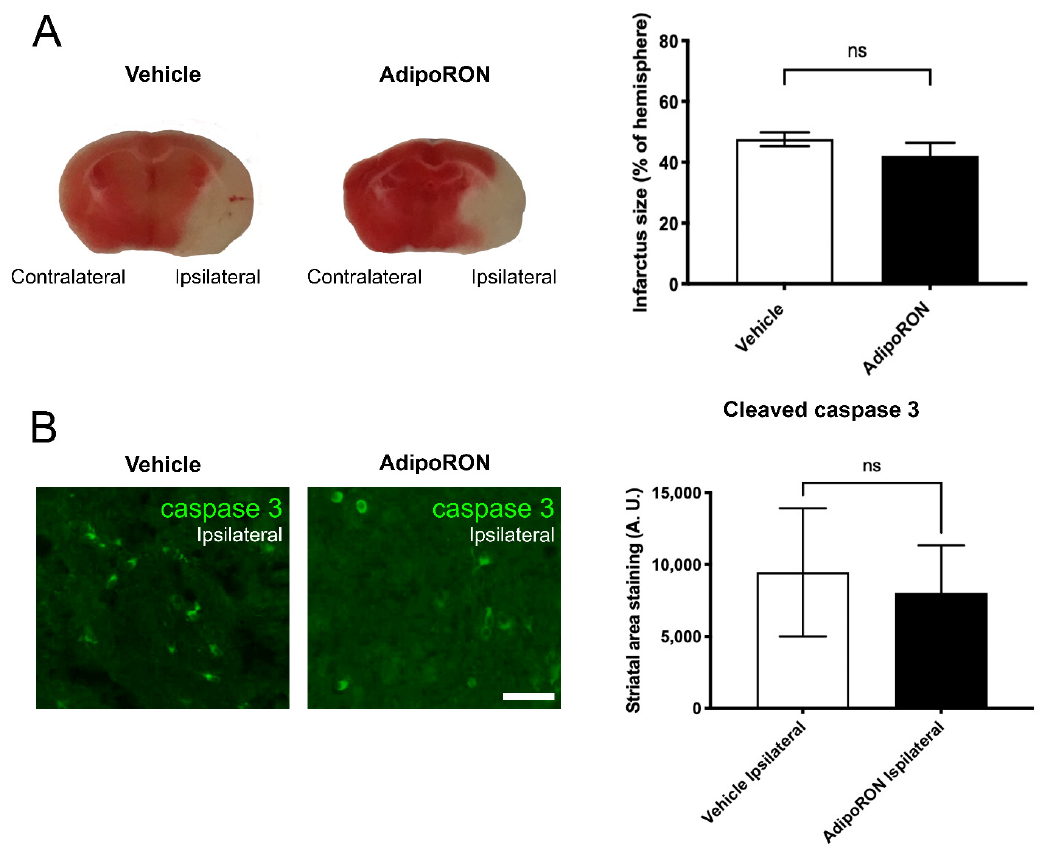
Figure 6. AdipoRON has no effect on the infarct size and on the number of activated caspase 3-positive cells 24 h post-stroke. ( A ) Representative coronal brain sections stained with TTC (ischemic/necrotic brain region is in white, and the alive region is in red) showing the contralateral and ipsilateral hemispheres. Quantification of the size of the infarcted area showing no difference between groups ( n = 8–10, p = 0.3158). ( B ) Representative immunohistostaining of activated caspase 3 (green) in the ipsilateral hemisphere of Vehicle and AdipoRON-treated mice. Quantification of cleaved caspase 3 staining in the striatal area of the ipsilateral hemisphere showing no significant difference between groups ( n = 4, p = 0.63). Scale bar = 40 µm ( B ) and 200 µm ( A ).